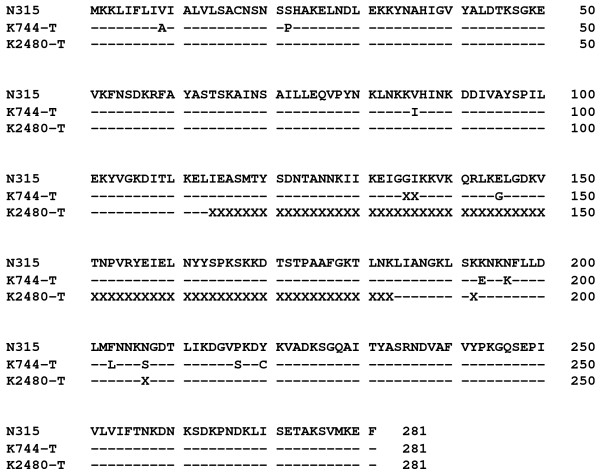
Amino acid sequence of theblaZgene in the transformant. The blaZ gene in the transformants K744-T and K2480-T as well as that of the donor plasmid pN315 was amplified by PCR using the primer pairs listed in Table 2. The nucleotide sequence was determined by the dideoxy chain termination method at Nippon Gene Research Laboratories (Miyagi, Japan). The nucleotide sequence was aligned by the computer programme, DNASIS Pro (Hitachi Software Engineering Co., Ltd., Tokyo, Japan), and was converted to the amino acid sequence. Amino acids are expressed by a single letter code. X mark denotes the amino acid residue, which could not be specified in this study. – denotes the amino acid residue, which is identical to that of pN315.